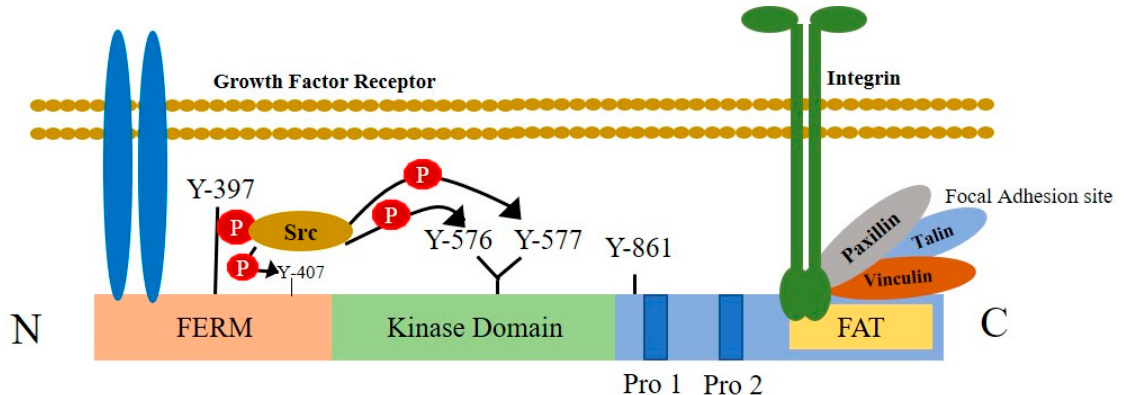
Figure 3. Structural features of focal adhesion kinase and its activation by cell-surface receptors. FAK is composed of a central kinase domain bordered by the N-terminal FERM homology domain and C-terminal region containing two proline-rich motifs and a FAT domain. The interaction of integrins with extracellular ligands, increases large macromolecular clusters on the cell cytoplasmic side that anchors the actin cytoskeleton to the plasma membrane in connection with the integrin-associated proteins talin, paxillin, and vinculin. This is known as the focal adhesion site. FAK connects with the focal adhesion sites of integrin through its C-terminal domain containing a focal adhesion targeting (FAT) sequence. The N-terminal FERM domain integrates signals from growth factor receptors. In response to extracellular stimuli, FAK activation causes the autophosphorylation of FAK at the Tyr397 residue and creates an SH2 domain docking site that interacts with proteins, such as Src. This interaction activates the Src tyrosine kinase, which further trans-phosphorylates other tyrosine residues placed on FAK and maximizes kinase